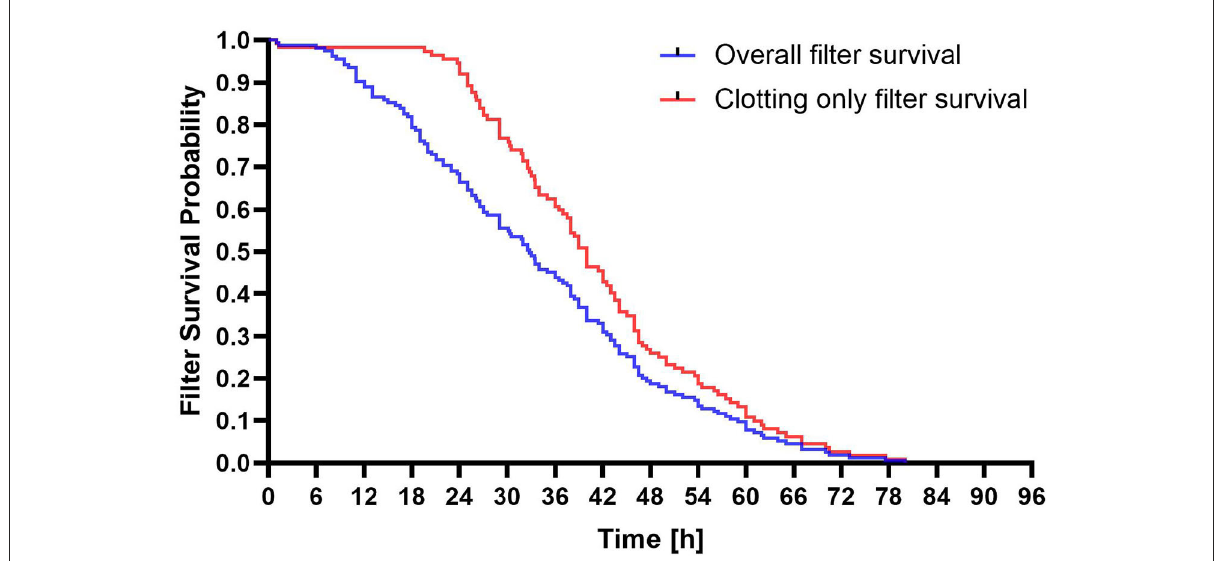
FIGURE2 Survival probability of filters of regional citrate anticoagulation and continuous renal replacement therapy (RCA-CRRT) circuits. Blue line: All filter discontinuations. Red line: Clotting only related filter